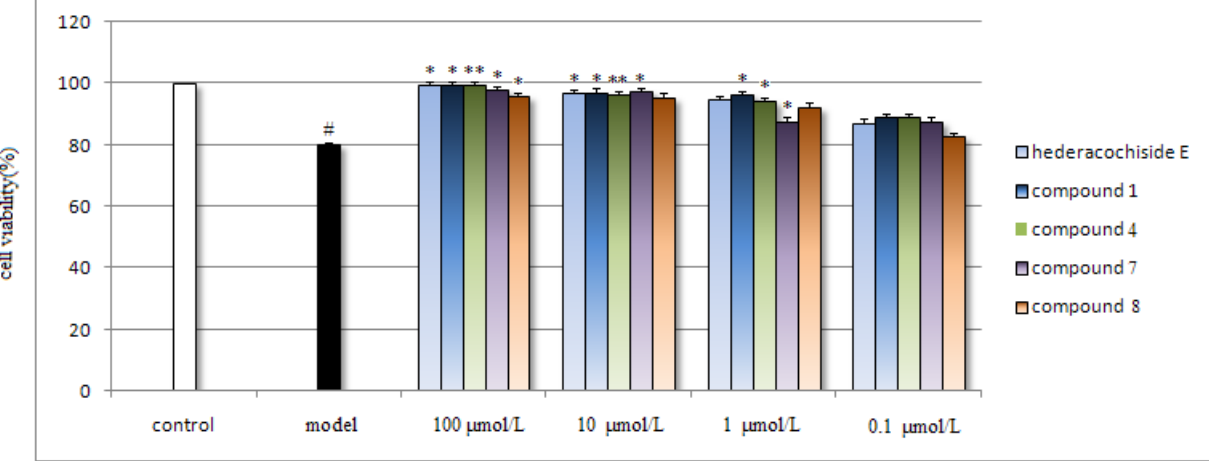
Figure 3. Effect of compounds 1 , 4 , 7 and 8 on cell ciability in A β